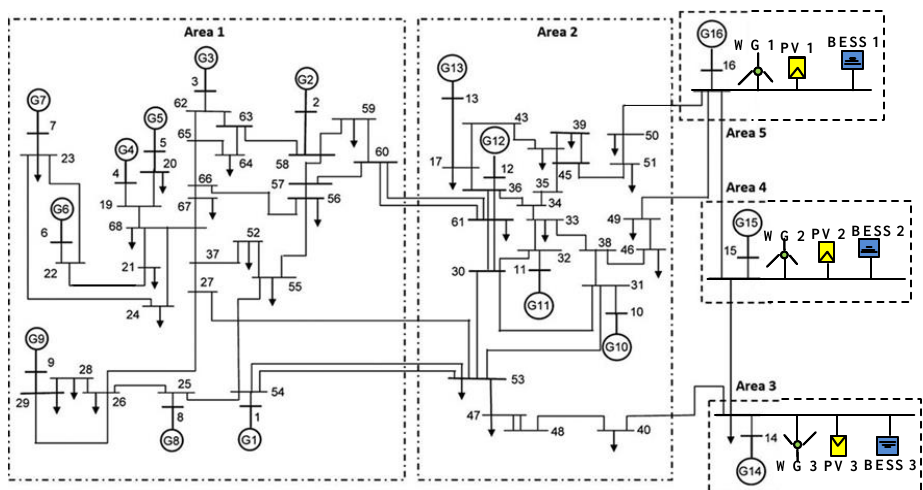
Figure 11. Modified test system with